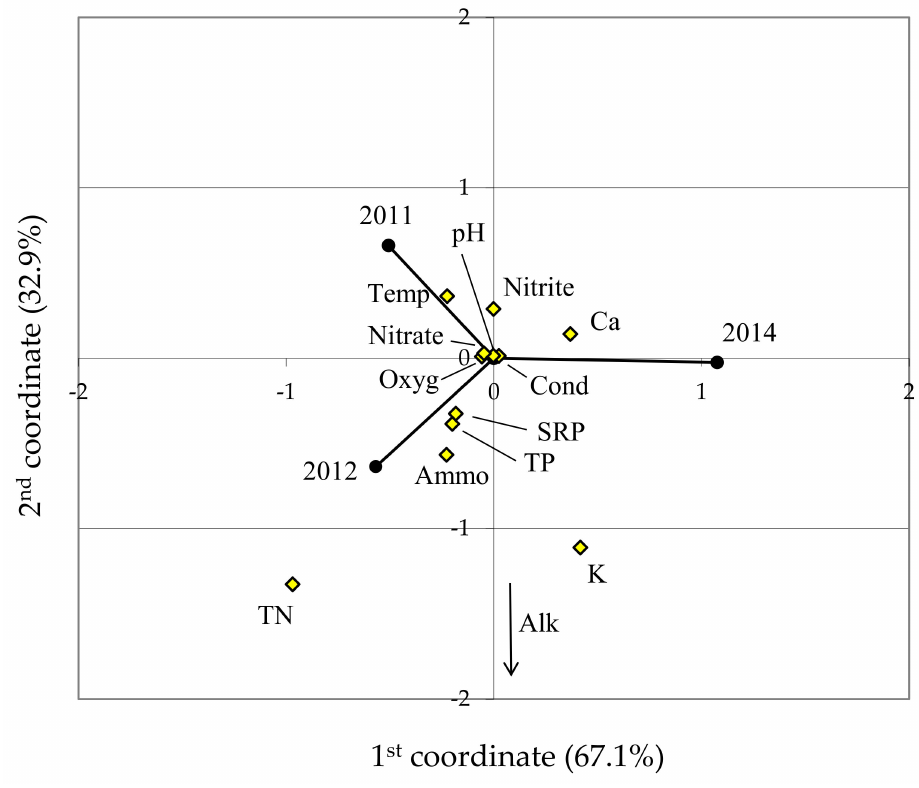
Figure 8. Position of selected years determined by physicochemical parameters in the space of the first two canonical varieties and spacing of these parameters in the dual space (trait coordinates rescaled and divided by